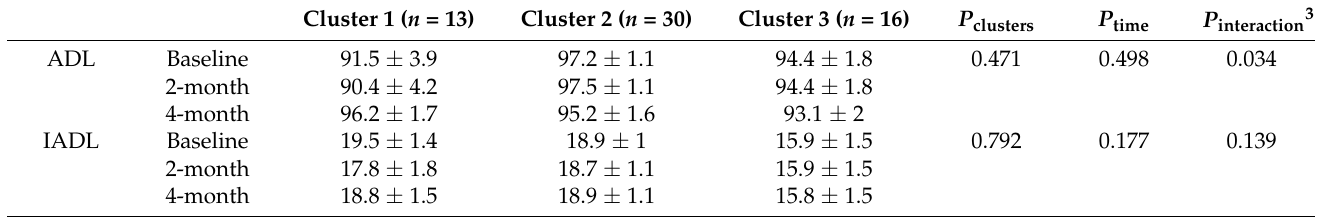
Table 4. Intervention effects on functional ability during the 4-month study period 1,2